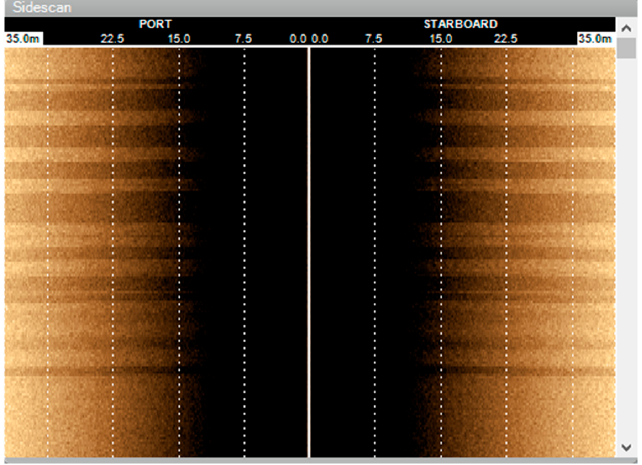
Figure 8. Sonar image with cables routed away.